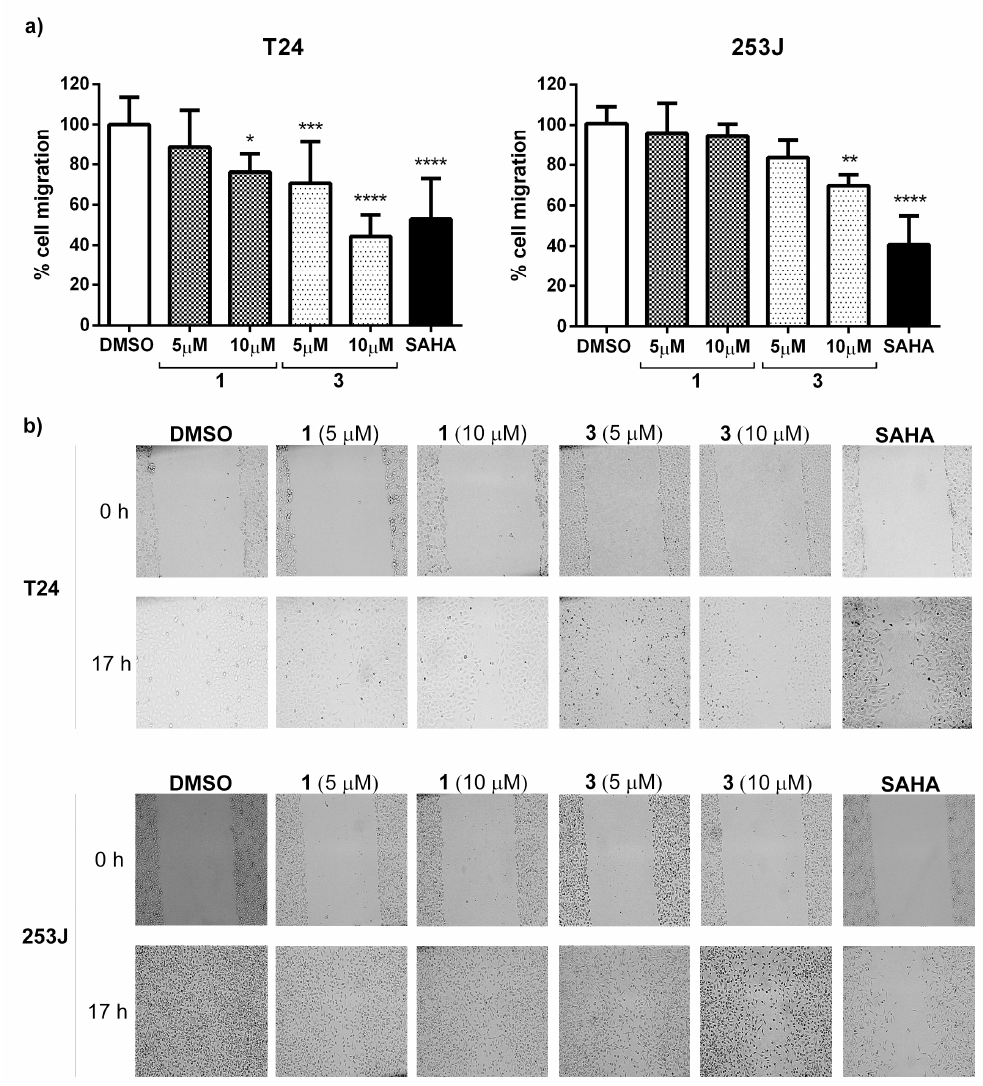
Figure 7. Effect of compounds on T24 and 253J cell migration. ( a ) Percentage of cell migration in the presence of compounds 1 and 3 at 5 and 10 µ M during a 17 h period. SAHA at 10 µ M was included as a positive control. The graph represents the mean ± standard deviation obtained from six measurements per well in three independent experiments. Statistical analysis was performed using one-way ANOVA test followed by Dunnett’s test with * p ≤ 0.05, ** p ≤ 0.01, *** p ≤ 0.001 and **** p ≤ 0.0001. ( b ) Representative images of the scratch assay from each experimental condition are shown in ( a ) graphical view at 0 and 17 h for both cell lines.